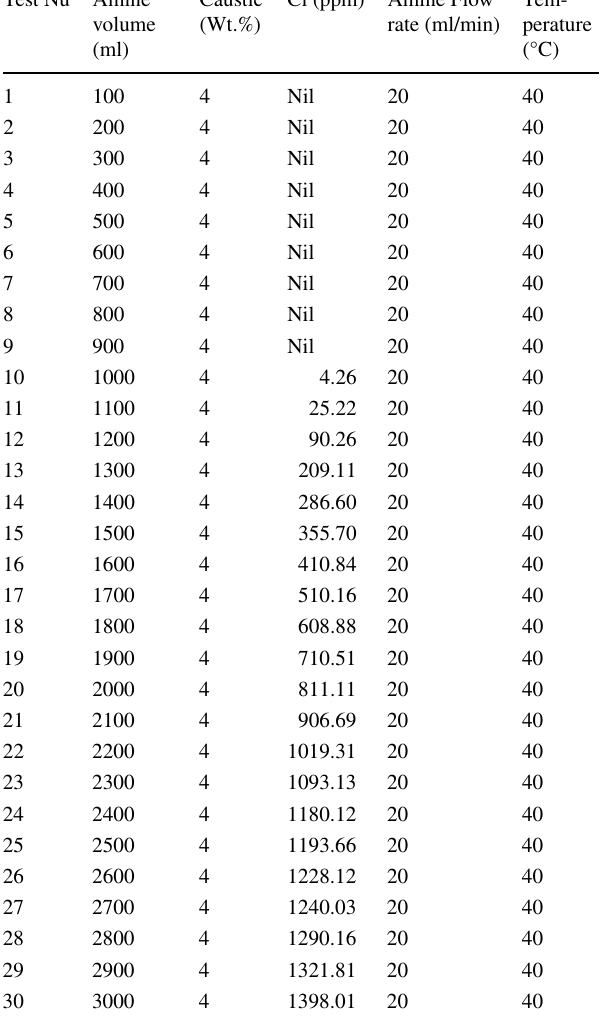
Table 3 Calculation of saturation time at 40